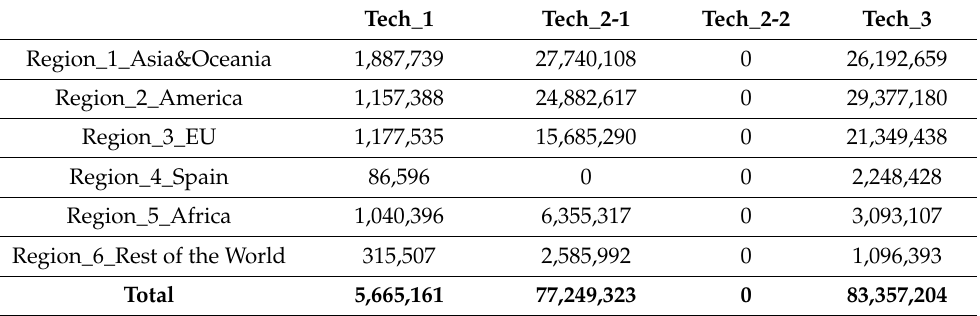
Table 9. Water split H M L, 2 technologies, M as H. Solution of x by region and technology (million